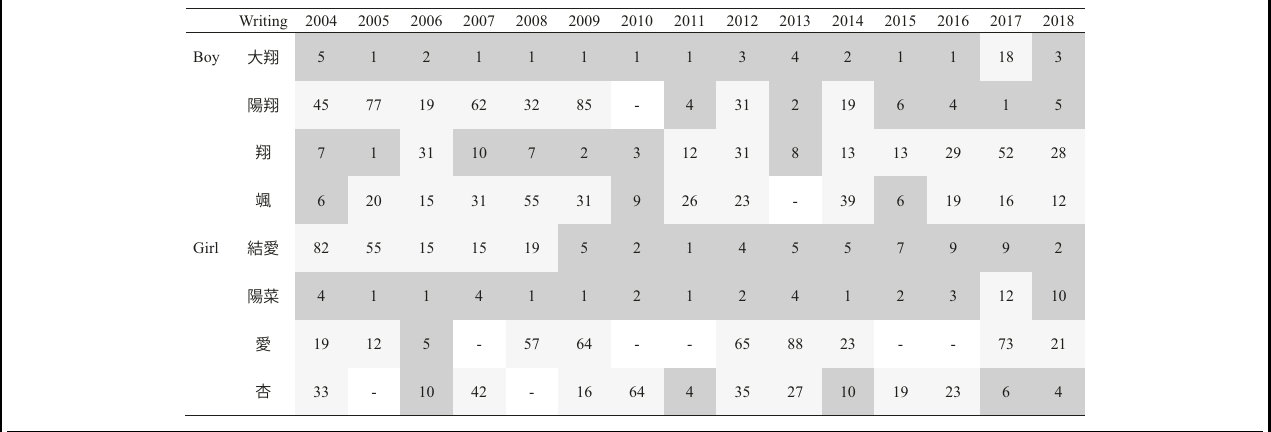
Cells with a dark color indicate the top 10 most common writings of names. Cells with a light color indicate the top 100 most common writings of names. – indicates not included in the top 100 most common writings of names. The values are based on surveys conducted by Meiji